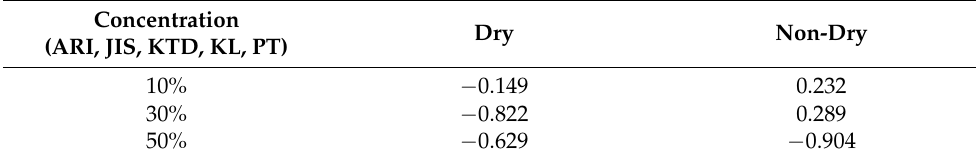
Figure 25. Viscosity versus cleaning rate comparison graph. ( a ) Concentration 10%; ( b ) concentration 30%; and ( c ) concentration 50%. Table 17. Correlation between cleaning rate and viscosity.